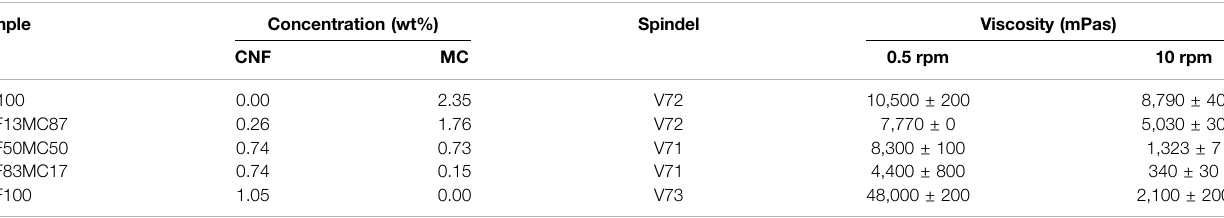
TABLE 1 | Concentrations of aqueous dispersions of CNF and MC and their corresponding Brook fi eld viscosities at rotational speeds of 0.5 and 10 rpm. The sample name indicate the ratio of the two stabilizers CNF and MC. Sample Concentration (wt%) Spindel Viscosity (mPas) CNF MC 0.5 rpm 10 rpm